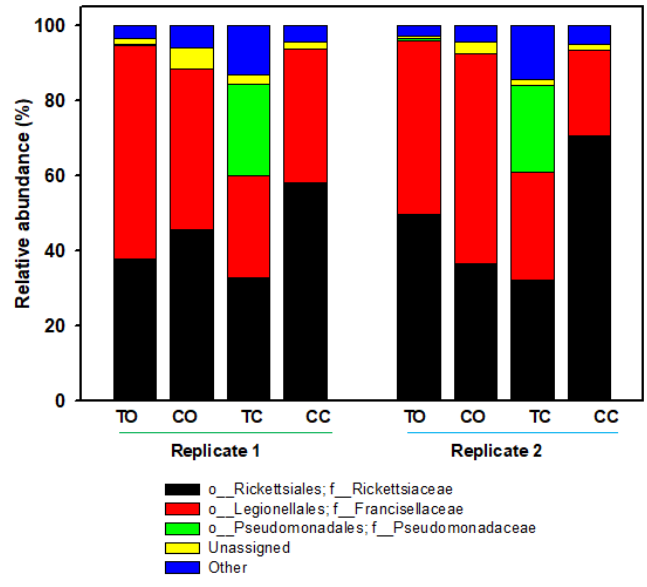
Figure 1. Relative abundance of major bacteria at the family level in part-fed (virgin) Dermacentor variabilis ovaries versus carcass for 20E versus control buffer injected ticks. Bars represent the proportions of each taxa. “Other taxa” = all other taxa with relative abundance <1% over the total number of reads. Abbreviations: TO, ovaries from ticks injected with 20-hydroxyecydsone (20E); CO, ovaries from ticks injected with control buffer; TC, carcass from ticks injected with 20E; CC, carcass from ticks injected with control buffer. Table 1. Summary of sequencing read